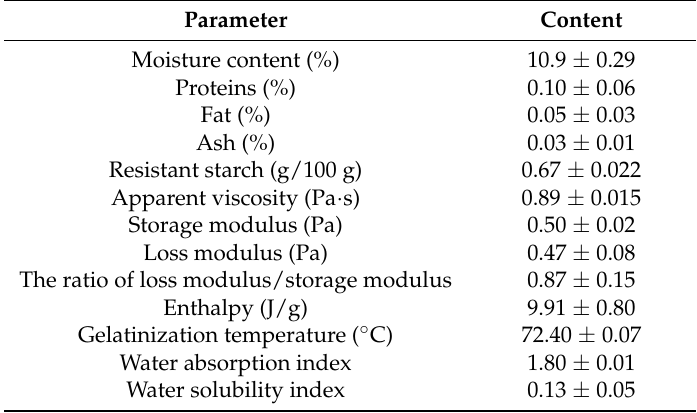
Table 1. Physicochemical characteristics of native